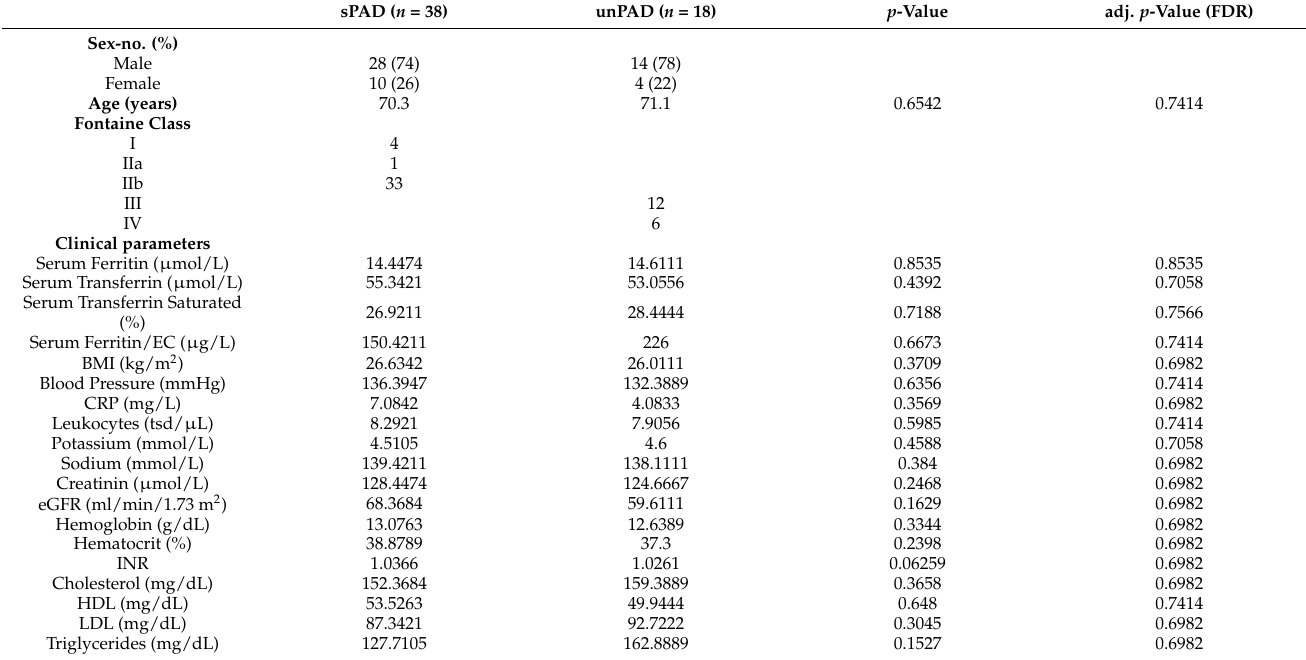
Table 1. Patient cohort characteristics: sPAD (Fontaine I, Fontaine II) and unPAD (Fontaine III, Fontaine IV) groups. sPAD: stable PAD, unPAD: unstable PAD; p -Value < 0.05 as significance level. sPAD ( n = 38) unPAD ( n =